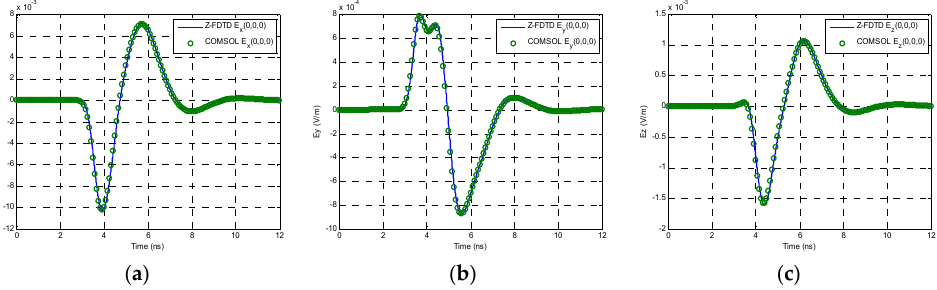
Figure 7. Three ‐ dimensional multi ‐ layer spheres with biaxial anisotropy where E (0,0,0) is denoted as the observation point in time domain. The center positions of multi ‐ layer spheres are fixed in (0, 0, 0), and radii of these spheres from the external layer to the internal layer are, respectively, 0.15 m, 0.10 m, and 0.05 m. The Z ‐ FDTD domain is 97 × 97 × 97 in size and Δ x = Δ y = Δ z = 0.005 m in the spatial cell; meanwhile, eight ‐ layered PML are applied to the truncation region. Moreover, the parameters of plane waves are denoted as E θ = 1, E φ = 3, θ inc = 70°, φ inc = 55°. By Gaussian pulse Equation (29) in the transient fields, the electric field observation point ( E x , E y , E z ) is captured within the propagating time of 12 ns, as shown in Figure 8. At that time, we can find in Figure 8 that their results are almost consistent with, respectively, 0.006, 0.0042, and 0.0053 in those norm errors. As reflected in Figure 9, the RCS results can be recorded at the frequency point f = 1 GHz when transient fields cover the whole Z ‐ FDTD region.